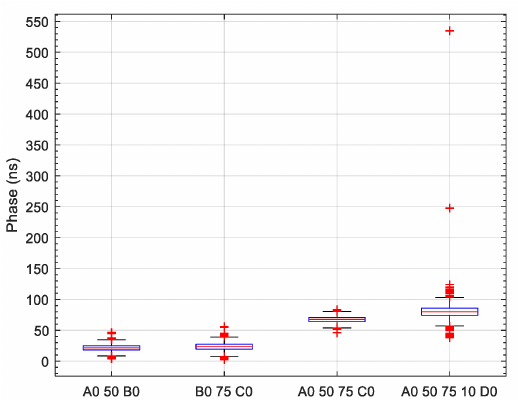
Figure 17. Box diagram for Sigma-Delta converters.